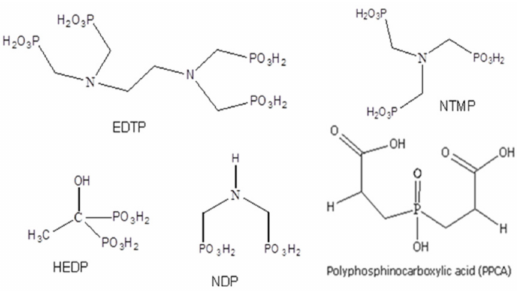
Figure 3. Molecular structures of some organo-phosphonate-based inhibitors (adapted from